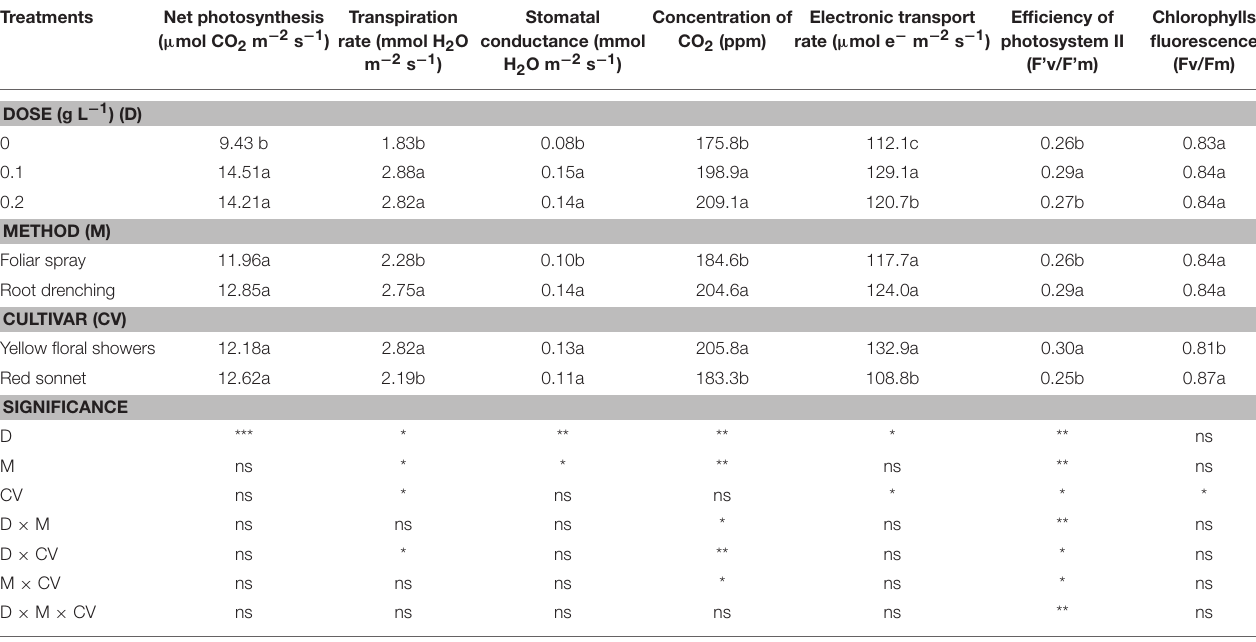
TABLE 7 | Main effects of biostimulant dose, application method and cultivar on net photosynthesis, transpiration rate, stomatal conductance, concentration of CO 2 , electronic transport rate, efficiency of Photosystem II and fluorescence parameters in snapdragon plants.